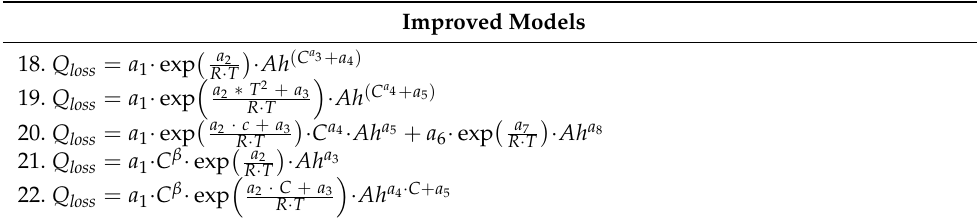
Table 7. The improved coupling-factor models based on Model 14. Improved